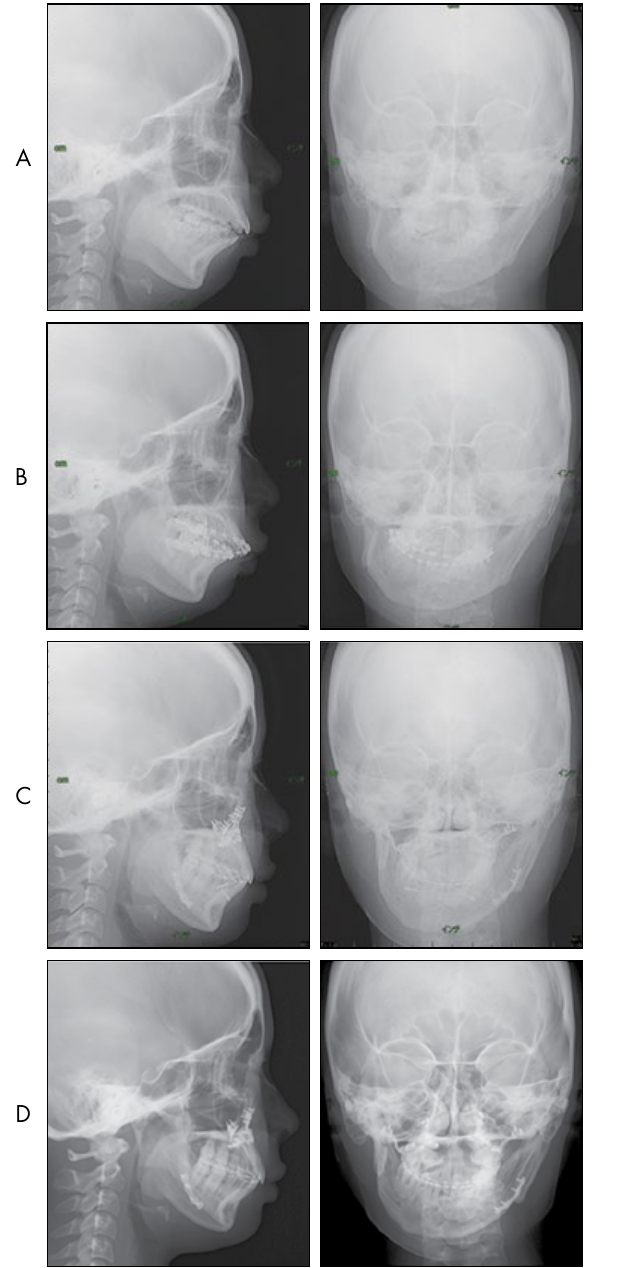
Figure 4. Lateral and Posteroanterior cephalograms. A: pretreatment; B: post first surgery; C: post-treatment, one year after surgery; D: post- retention, two years and six months after surgery.